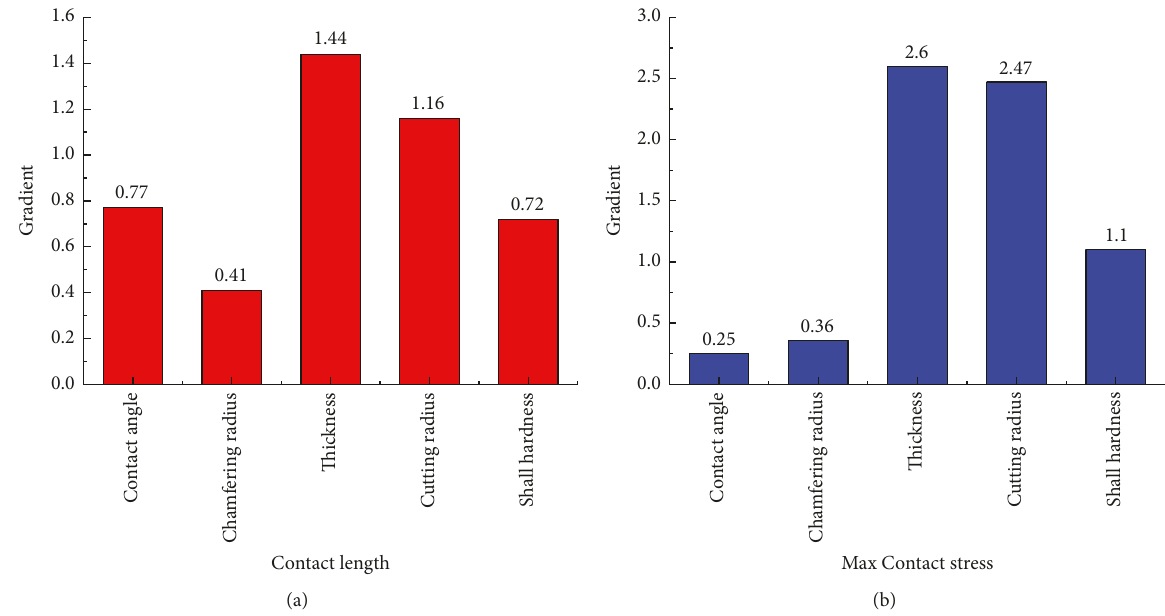
Figure 32: Column distribution of max contact stress and contact length. (a) Contact length. (b) Max contact